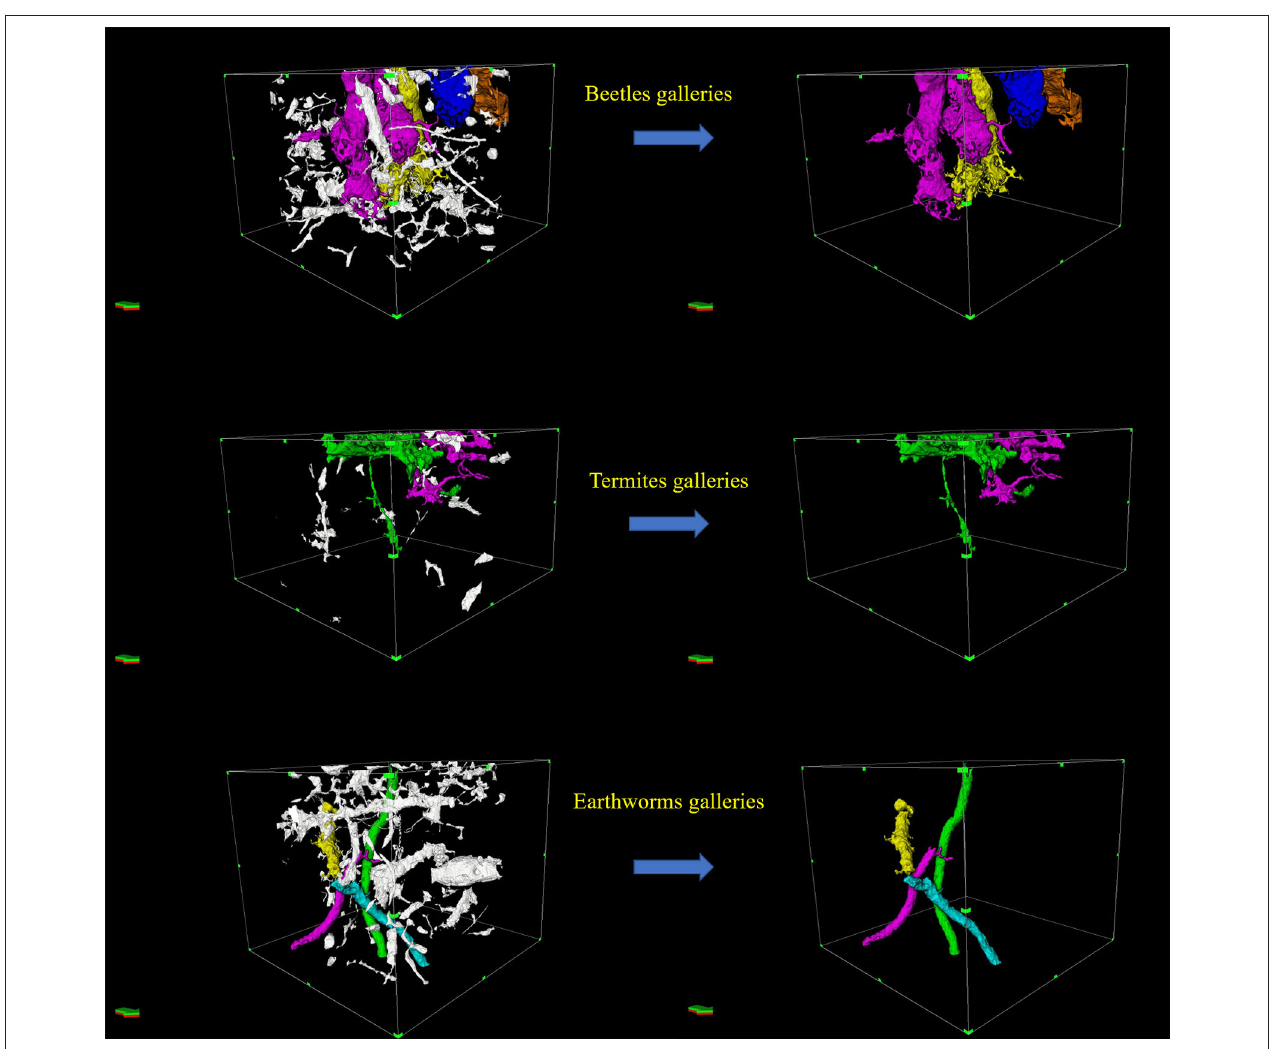
FIGURE 3 | Examples of three-dimensional images of galleries made by beetles, termites and earthworms ( Right ) manually isolated from macropores (in white: Left